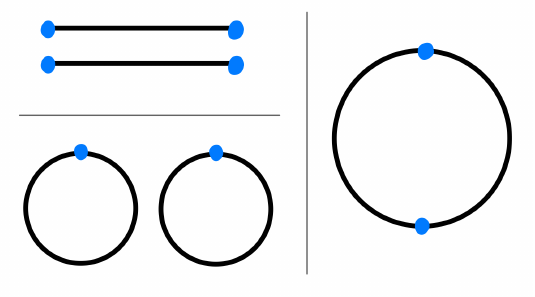
Figure 7 . The three equivalent path integrals. Top left: two intervals of size β with all their ends identified (in blue). Bottom left: two circles of length β , with the point τ = 0 identified between them. Right: one circle of length 2 β , with the points τ = 0 , β further identified. Two